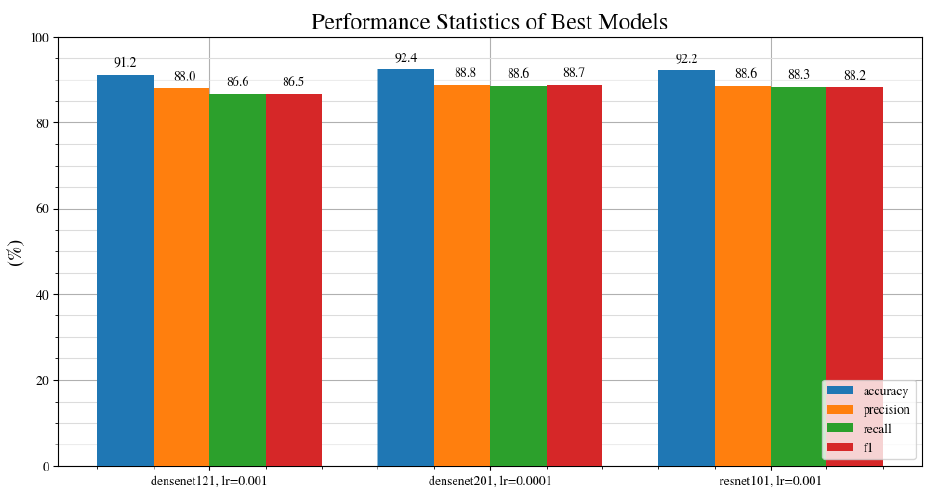
Figure 5. Accuracy, precision, recall and f1 score metrics for the top three performing